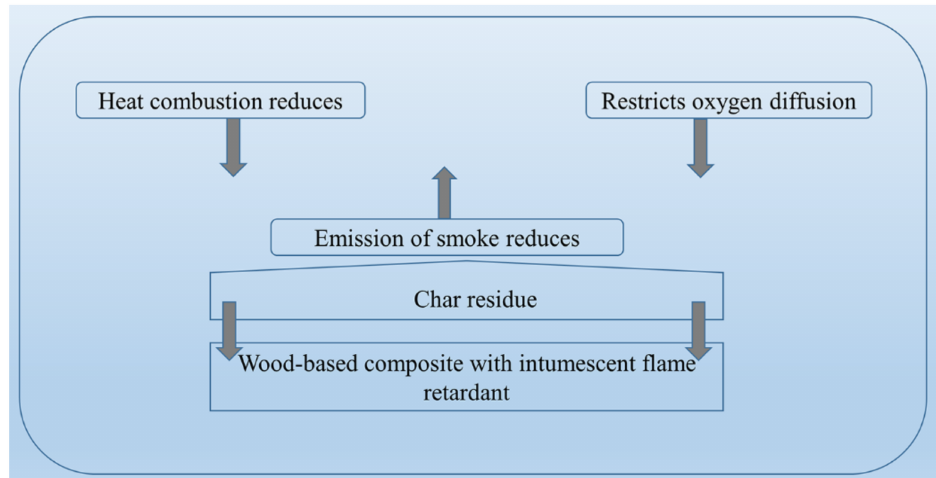
Figure 3. Intumescent flame retardant mechanism (reprint from